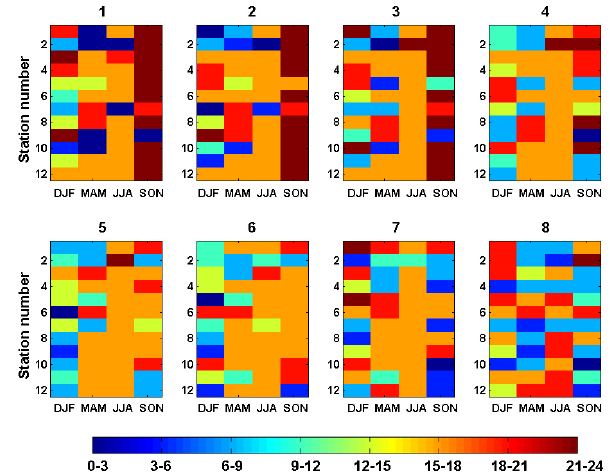
Figure 4. UTC time (hour of a day) of the diurnal cycle peak. Eight subplots correspond to eight precipitation intensity bins defined in Table 3, and each subplot shows peak times for the 12 stations and four